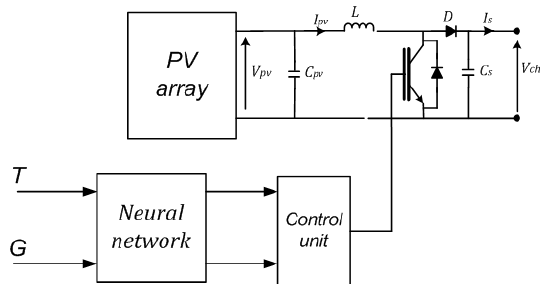
Figure 9. MPPT ANN controller block diagram.